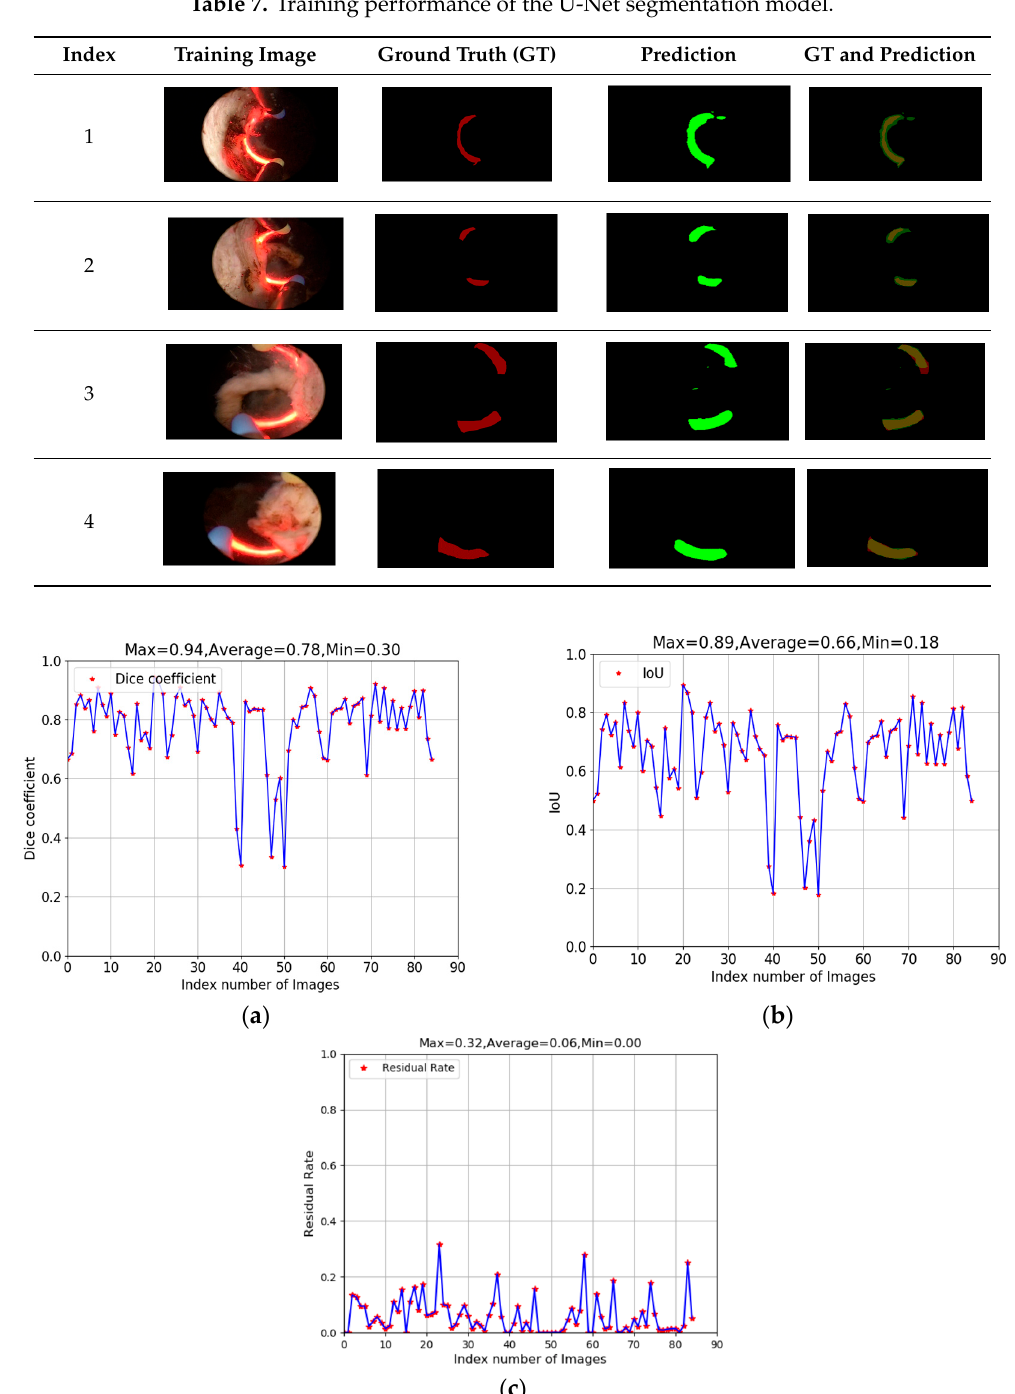
Table 7. Training performance of the U-Net segmentation model.